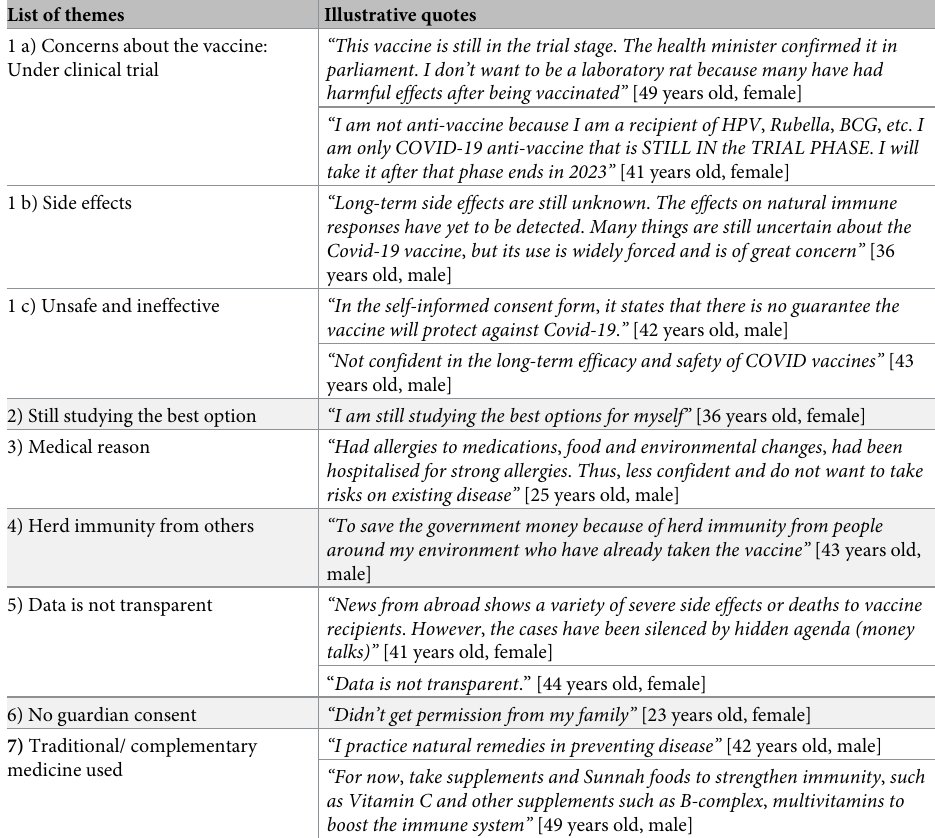
Table 3. Analysis of themes for the reasons resulting in vaccine